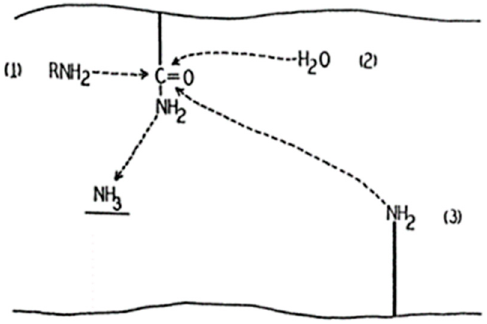
Figure 1. First draft of the transglutaminase catalyzing reaction [53].